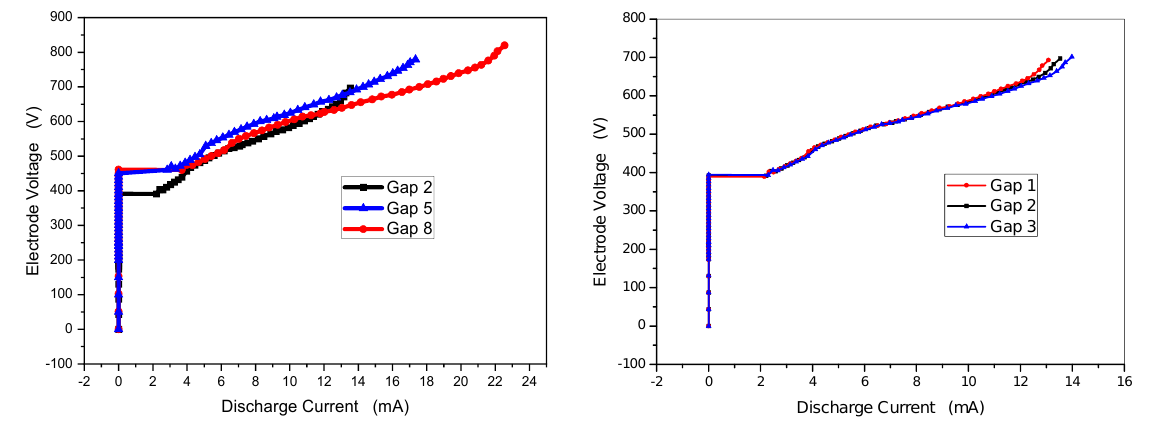
Figure 4: V − I characteristic curves for different gaps. Figure 5: V − I characteristic curves for similar